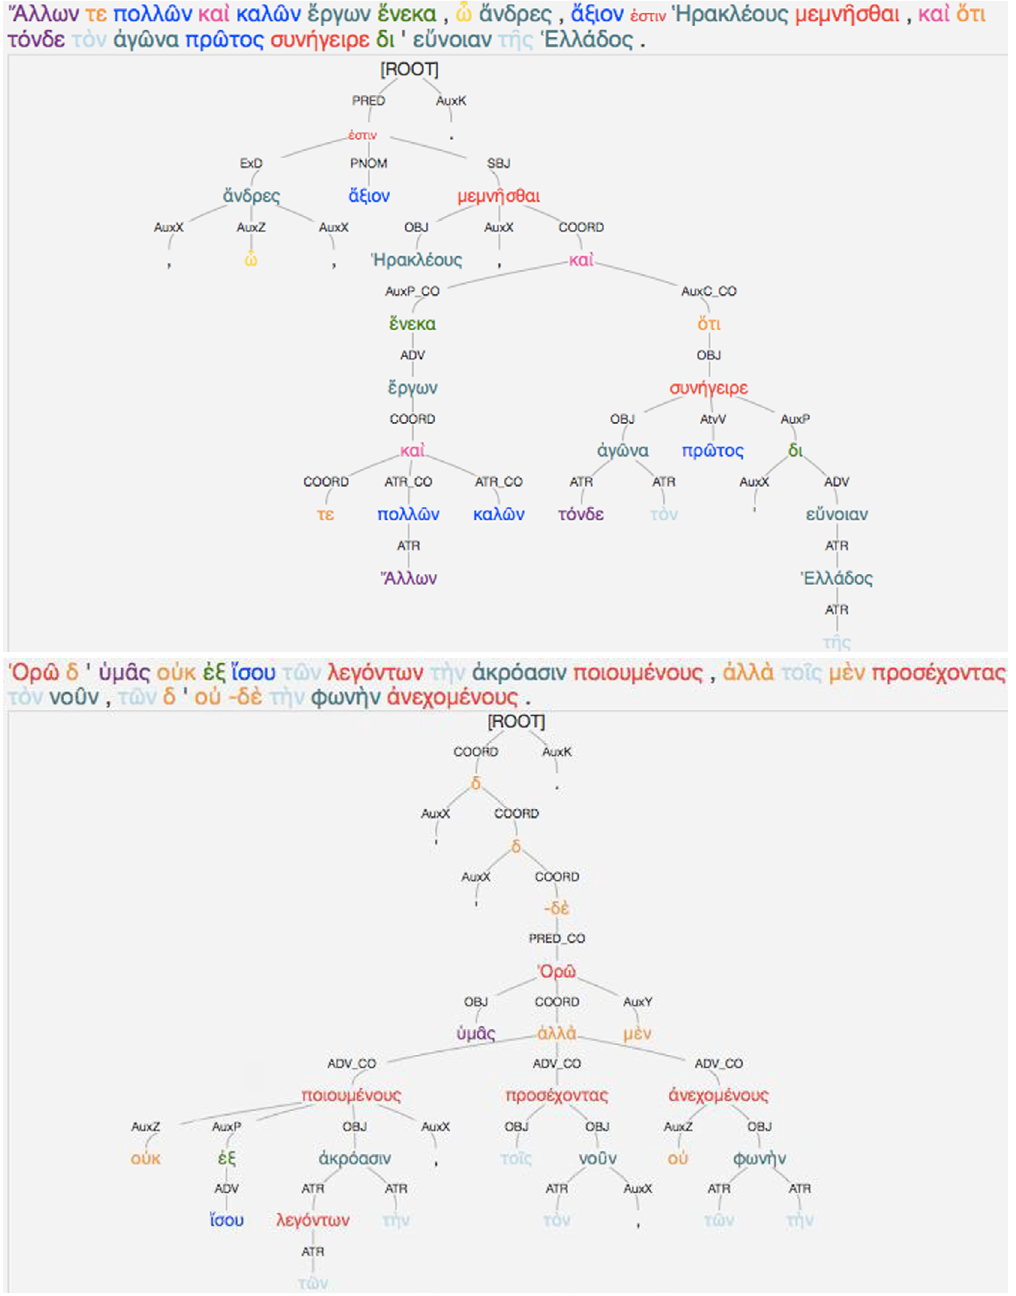
Fig 1. Syntactical comparison of Lysias’ Olympiacus 1.1 (top) and Isocrates’ De pace 3.1 (bottom). The Treebank annotation furnished showcases that Lysias’ sentence is more tightly composed with just one secondary clause that is parallel to the prepositional phrase introduced with ἕνεκα. The two sub-branches depending on the coordination καί give the sentence a structured and balanced form. Isocrates, on the other hand, after having introduced two major coordinations δέ, also explores the affluence of the Greek in participles and with one coordination introduces three sub-brances of three supplementary participles, all dependent on the same main